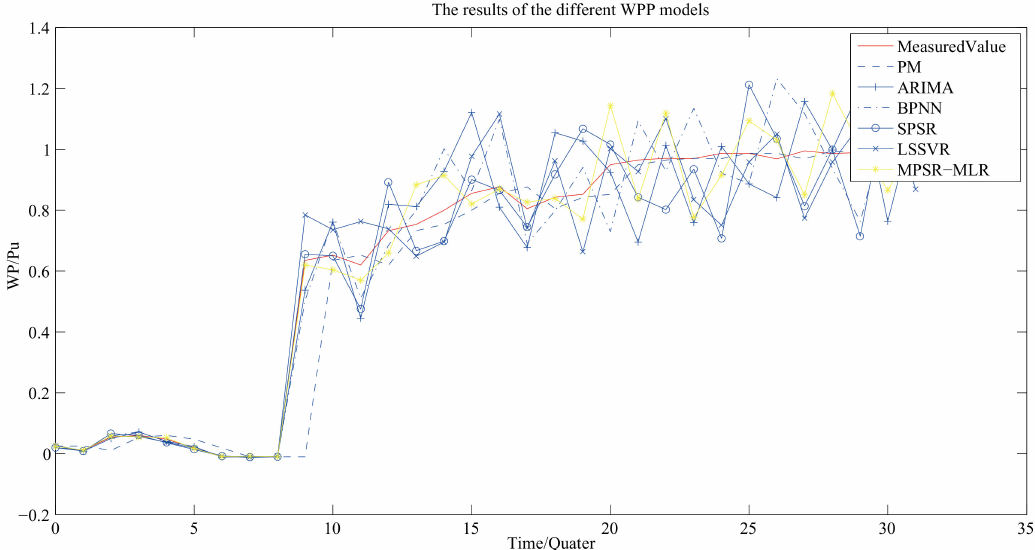
Figure 7. Results of wind power predictions. ‘Measured Value’ is the measurement of wind power. ‘PM’ is the forecasting results of persistence method. ‘ARIMA’ is the forecasting results of the autoregressive integrated moving average. ‘BPNN’ is the forecasting result of the back propagation neural networks [37]. ‘SPSR’ is the forecasting of the WPP based on single-variable phase space reconstruction. ‘LSSVR’ is the forecasting results of the WPP based on LSSVR. ‘MPSR-MLR’ is the forecasting results of the proposed model.